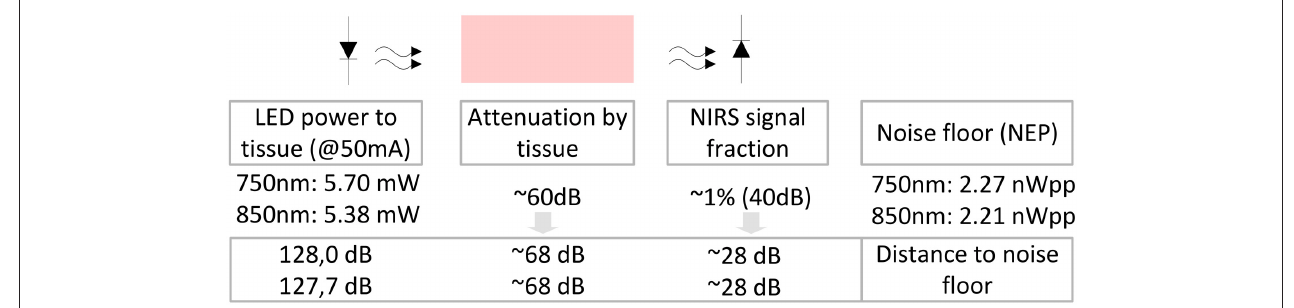
FIGURE 7 | Estimation of signal and noise in the instrument: With the NEPs identified to be 2.27/2.21nWpp, the distance between these optical powers equivalent to the noise floor of the detection circuit and the measured powers incident to the tissue ( 5.70 mW/ 5.38 mW) at medium LED illumination can be determined to be approximately 128dB/127.7dB, respectively. The degree of optical loss of the incident light in the tissue is subject dependent. Here, we estimate it to be in the order of at least 40–60dB. With the actual metabolic fNIRS signal being in the order of 1% of the measured optical signal, the distance of the fNIRS signals to the noise floor is approximately 28dB.